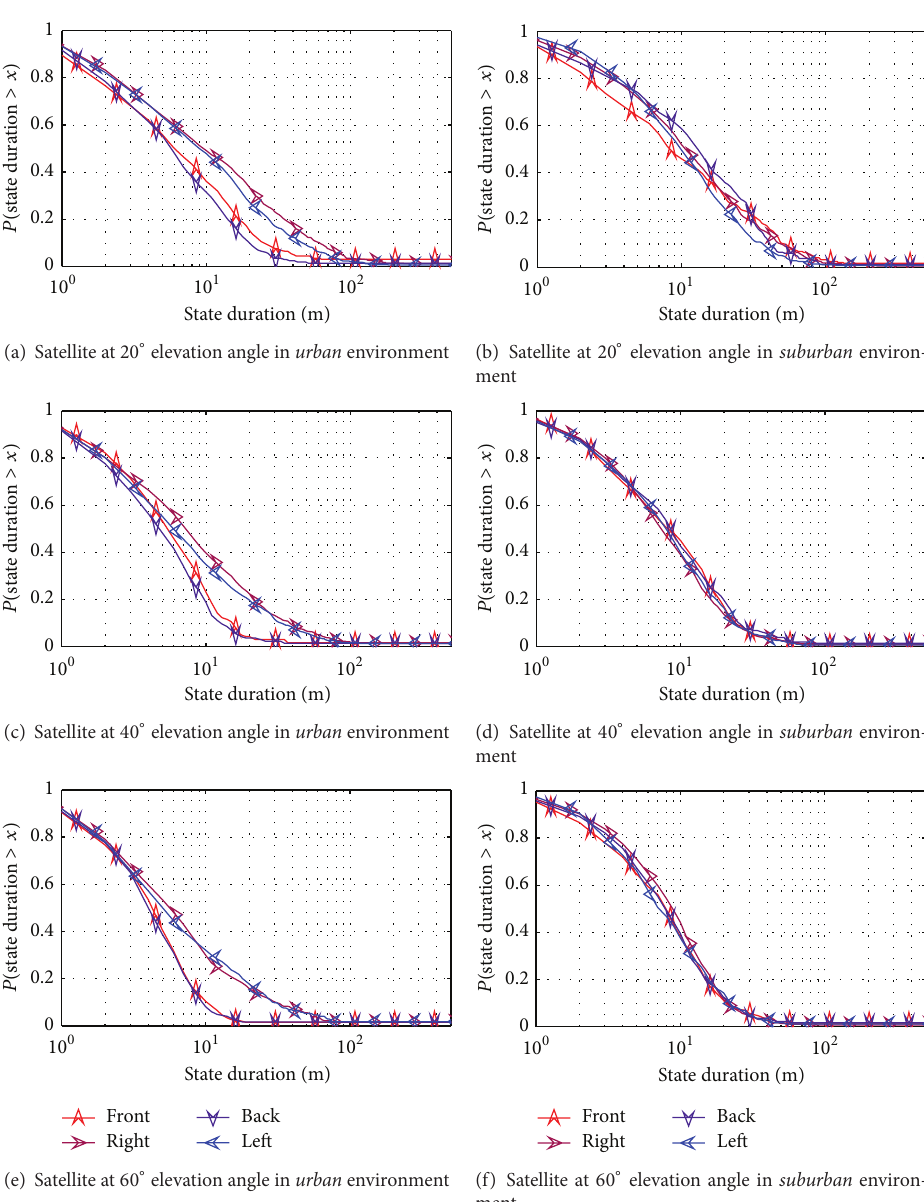
Figure 14: State duration statistics for the bad state with respect to different driving directions and elevation angles in urban (left) and suburban environment